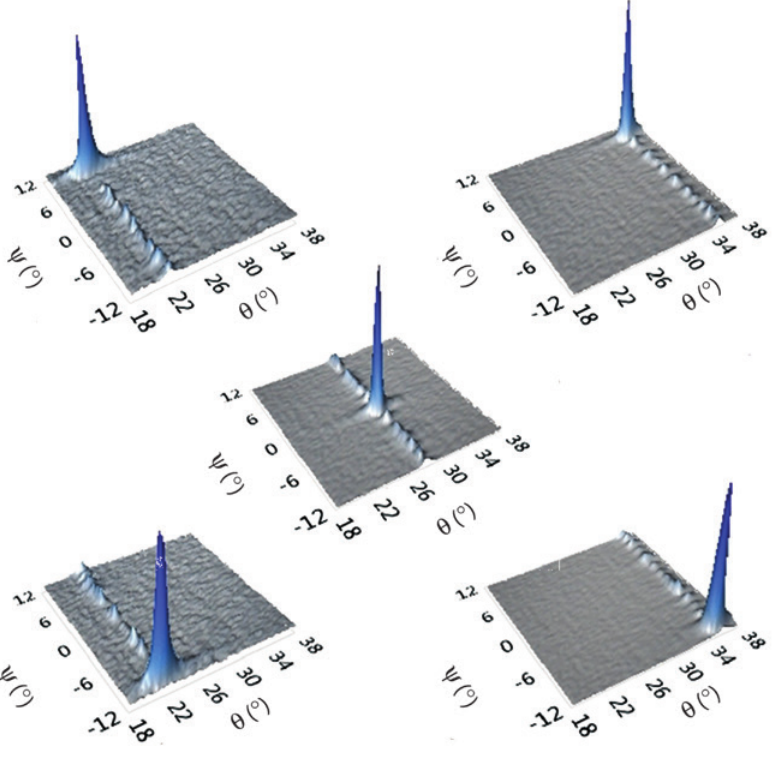
Figure 10: Plots of the beam profiles obtained with the silicon photonic OPA presented in Ref. [31], showing steering over the field of view, which is defined to exclude secondary peaks. Reprinted (adjusted) by permission of The Optical Society.